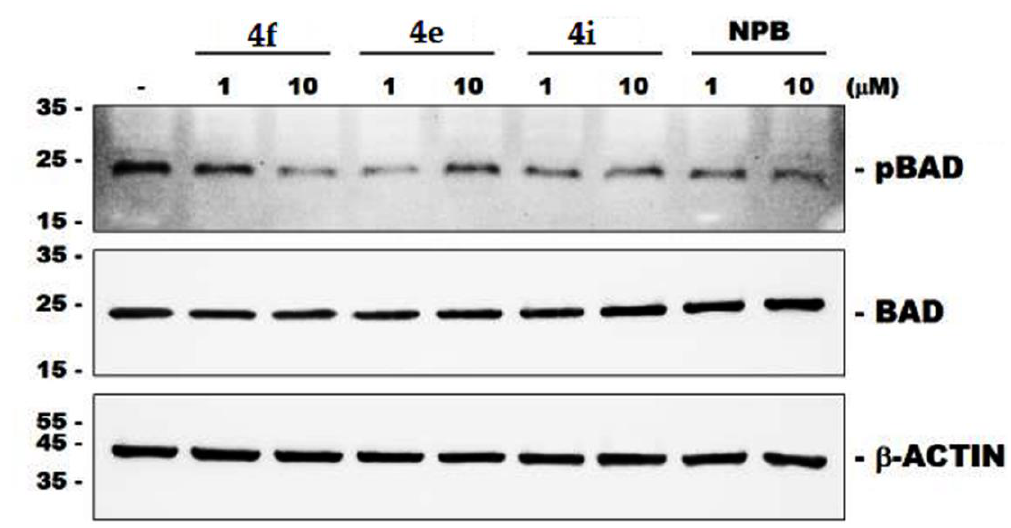
Figure 6. Western blot analysis of expression of hBAD (BAD) and Ser-99 phosphorylation (pBAD) of hBAD after treatment of MCF-7 cells with NPB analogs ( 4f , 4e , and 4i ). β -ACTIN was used as input control.